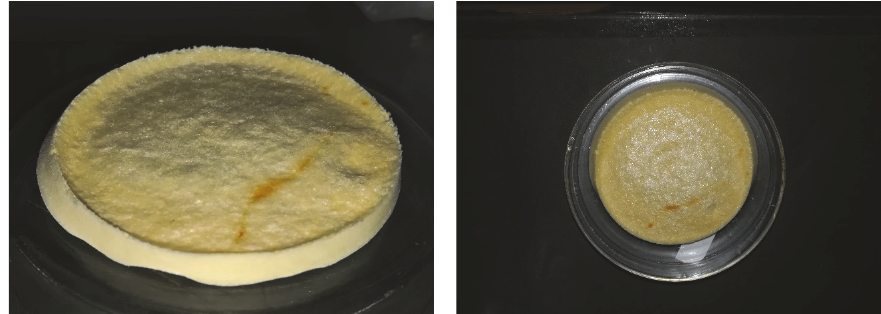
Figure 1: Lyophilized sample scaffold of chitosan/TiO 2